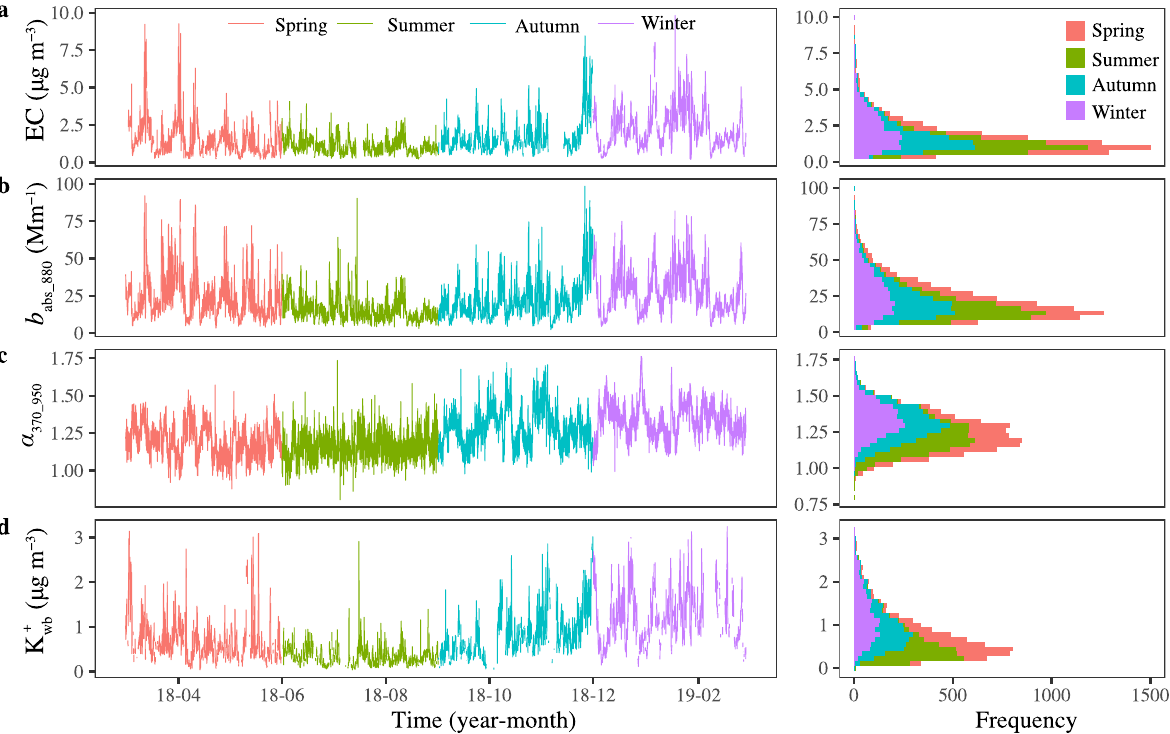
Fig. 1 Time series and distribution characteristics of key variables during the observational period. a Elemental carbon (EC). b Aerosol light absorption at 880 nm ( b abs_880 ). c Absorption Ångström exponent was calculated by power-law fi t at 7 wavelengths from 370 to 950 nm ( α 370_950 ). d Potassium from wood burning ( K þ ). The colors in the fi gures represent different seasons (Spring: March, April, and May; Summer: wb June, July, and August; Autumn: September, October, and November; Winter: December, January, and